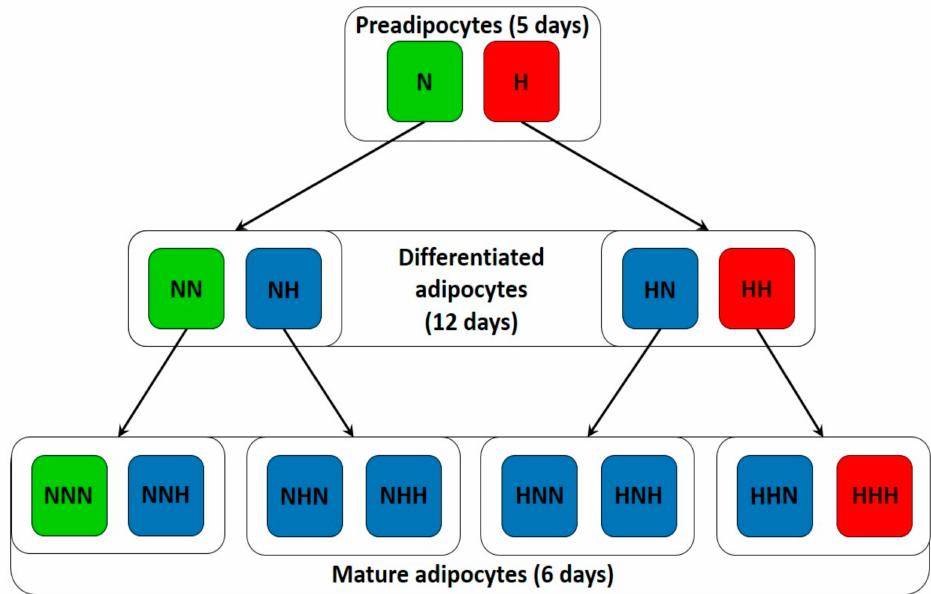
Figure 1. The stages of adipogenesis of HPA-v cells carried out under normoglycemia (NG, green), chronic hyperglycemia (HG, red) and intermittent HG (blue). While “H” denotes hyperglycemic treatment, “N” indicates normoglycemic culture